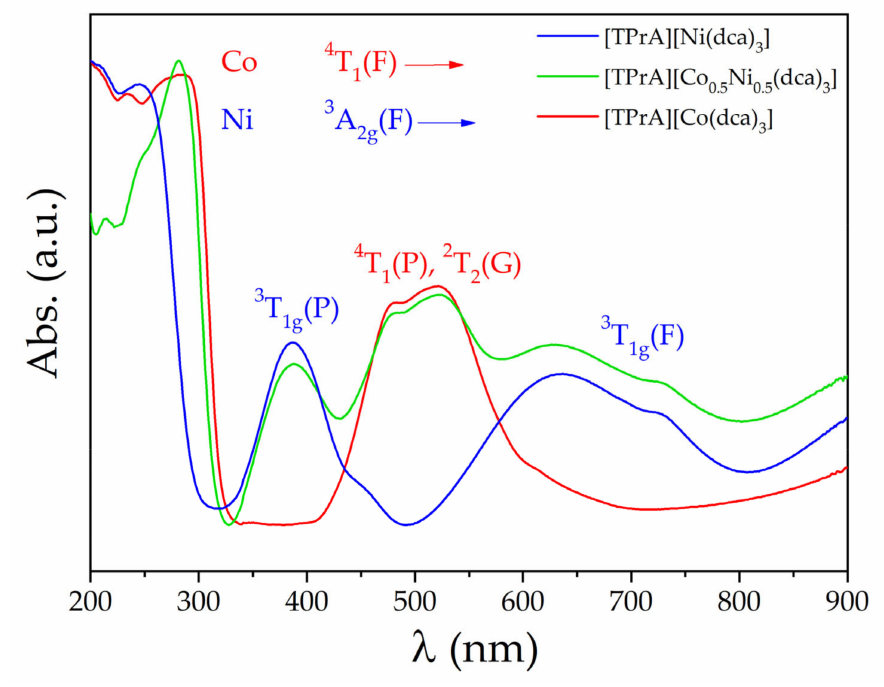
Figure 8. UV-Vis spectra of [TPrA][Co x Ni 1 − x (dca) 3 ], where x = 1.0, 0.5 and 0.0, between 200 and 900